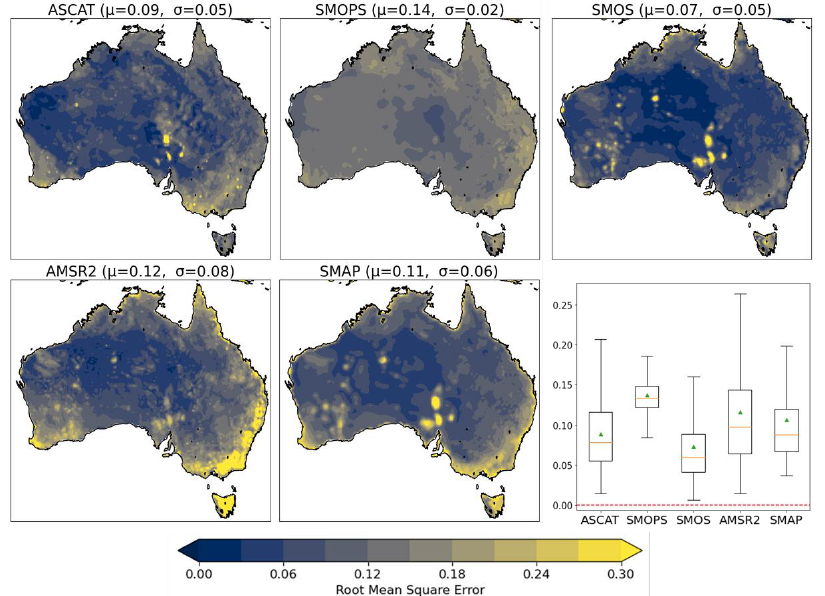
Figure 8. Temporal RMSE results depicted spatially for ASCAT, SMOPS, SMOS, AMSR-2, and SMAP. An accompanying box-whisker plot depicts the spatio-temporal results — whiskers extend out to show the interquartile range, the orange line indicates the distribution median, and the green triangle indicates the distribution mean, red dashed line indicates perfect value.